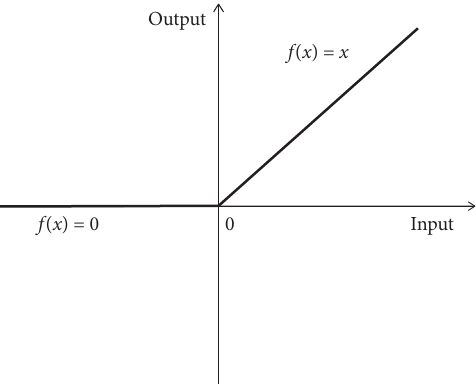
Figure 6: Architecture of DNN.